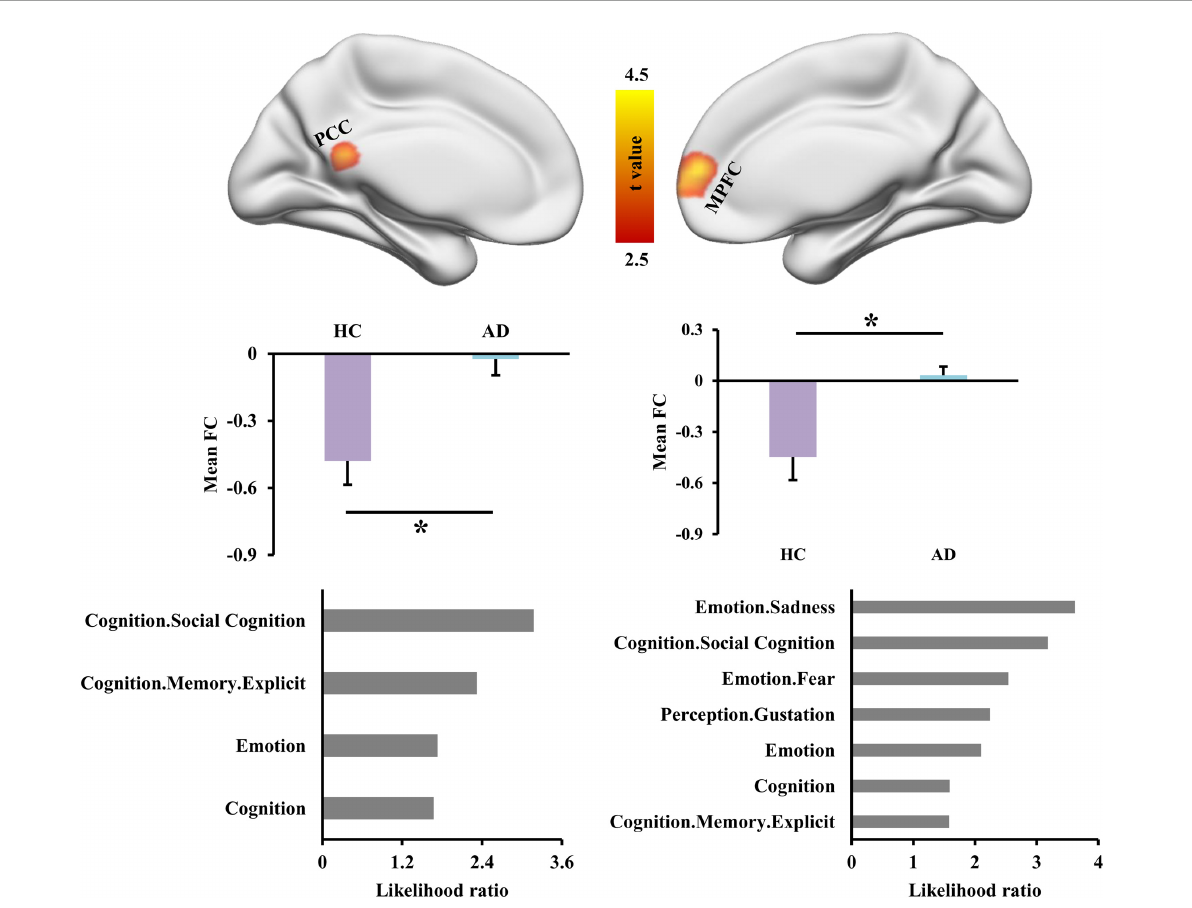
FIGURE2 Altered functional connectivities of left dorsal anterior insula (INS) in Alzheimer’s disease (AD) patients. Whole brain voxel-wise functional connectivity analysis identified significantly increased functional couplings between INS and posterior cingulate cortex (PCC) and medial prefrontal cortex (MPFC) in AD patients compared to healthy controls. The functional characterization of PCC found that this area is mainly involved in social cognition, memory, emotion, and cognition. The MPFC was also found to mainly participate in sadness, social cognition, fear, gustation, cognition, and memory. *Represents a significant